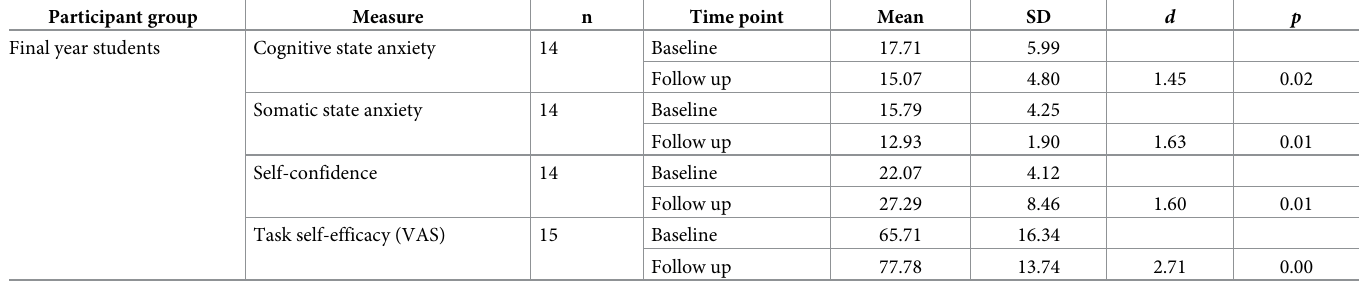
Table 2. Repeated measure study comparing anxiety and confidence (using the CSAI-2 and purpose-built questionnaire (VAS)) outcomes prior (baseline) and fol- lowing (follow up) a half-day foot ulcer management workshop using 3D printed foot ulcer models in final year students. Participant group